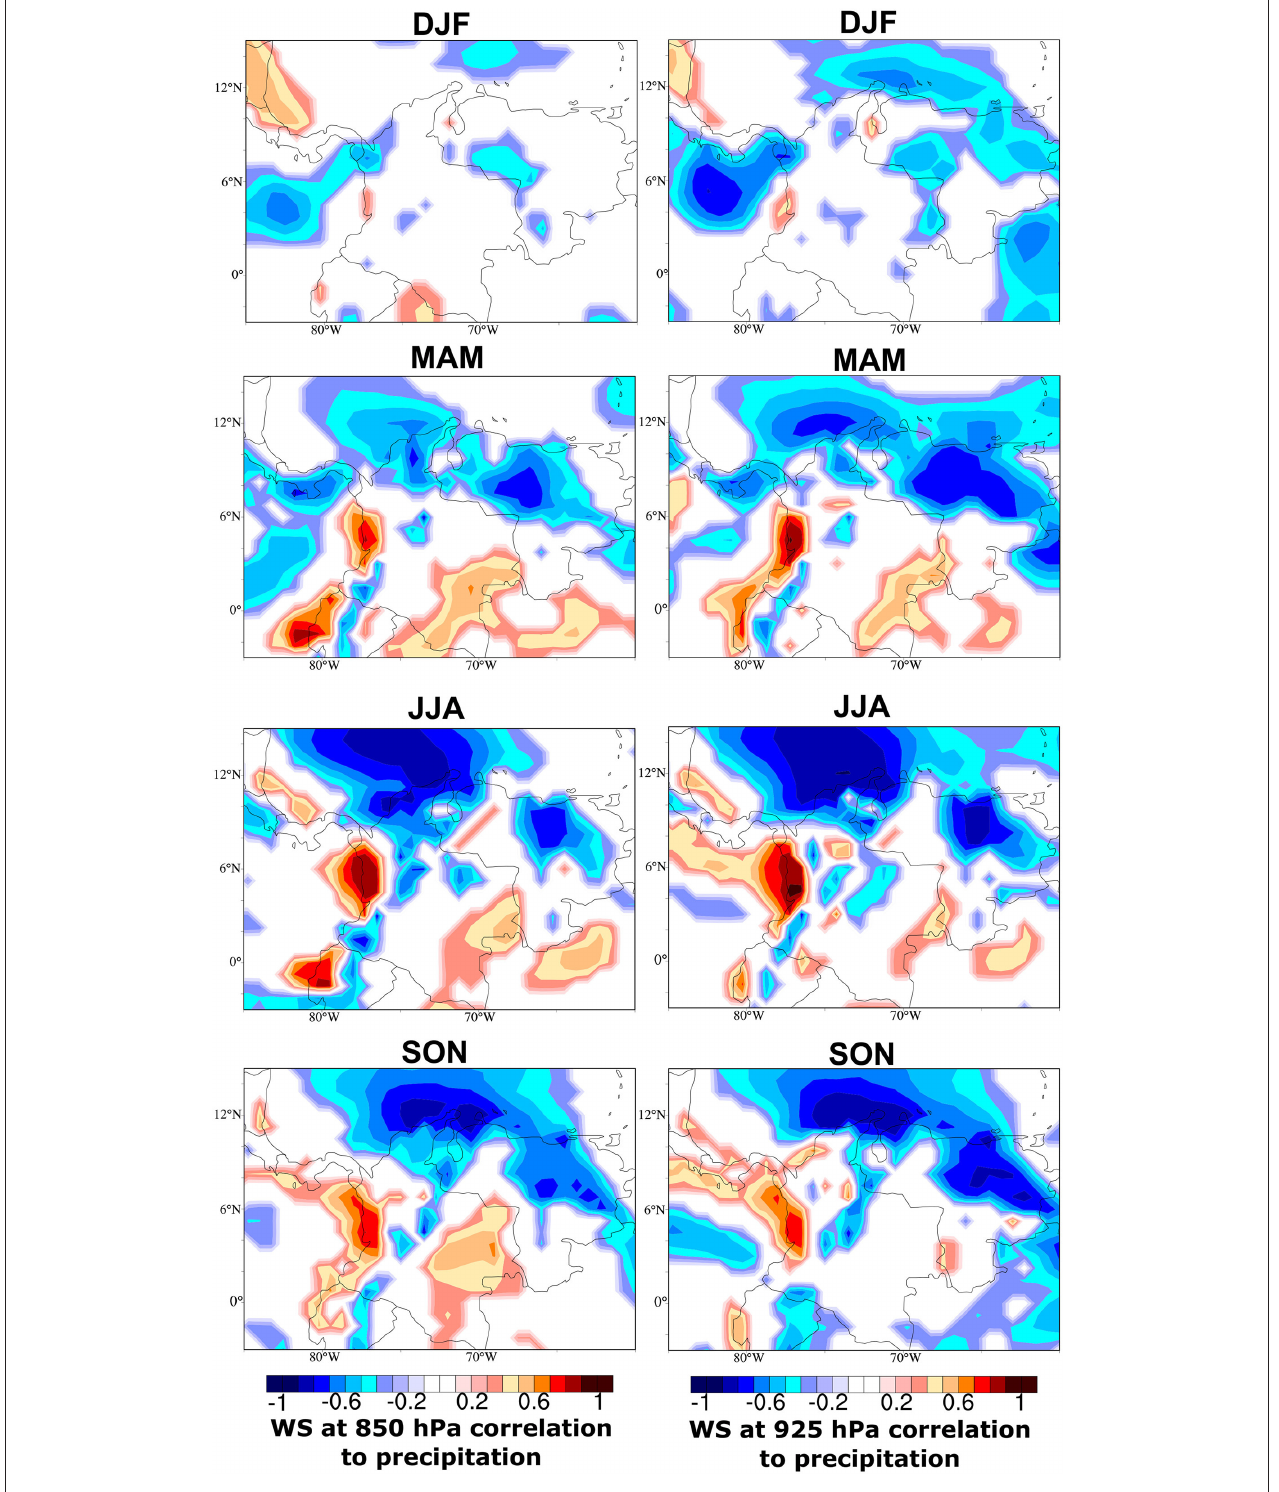
FIGURE 8 | Seasonal iso-correlations between wind speeds at 850 hPa (left)/ 925 hPa (right) and precipitation rates over Colombia for the 1979-2017 period. Data source: ERA-Interim Reanalysis, prepared using the Climate Reanalyzer (https://ClimateReanalyzer.org), Climate Change Institute, University of Maine, USA.